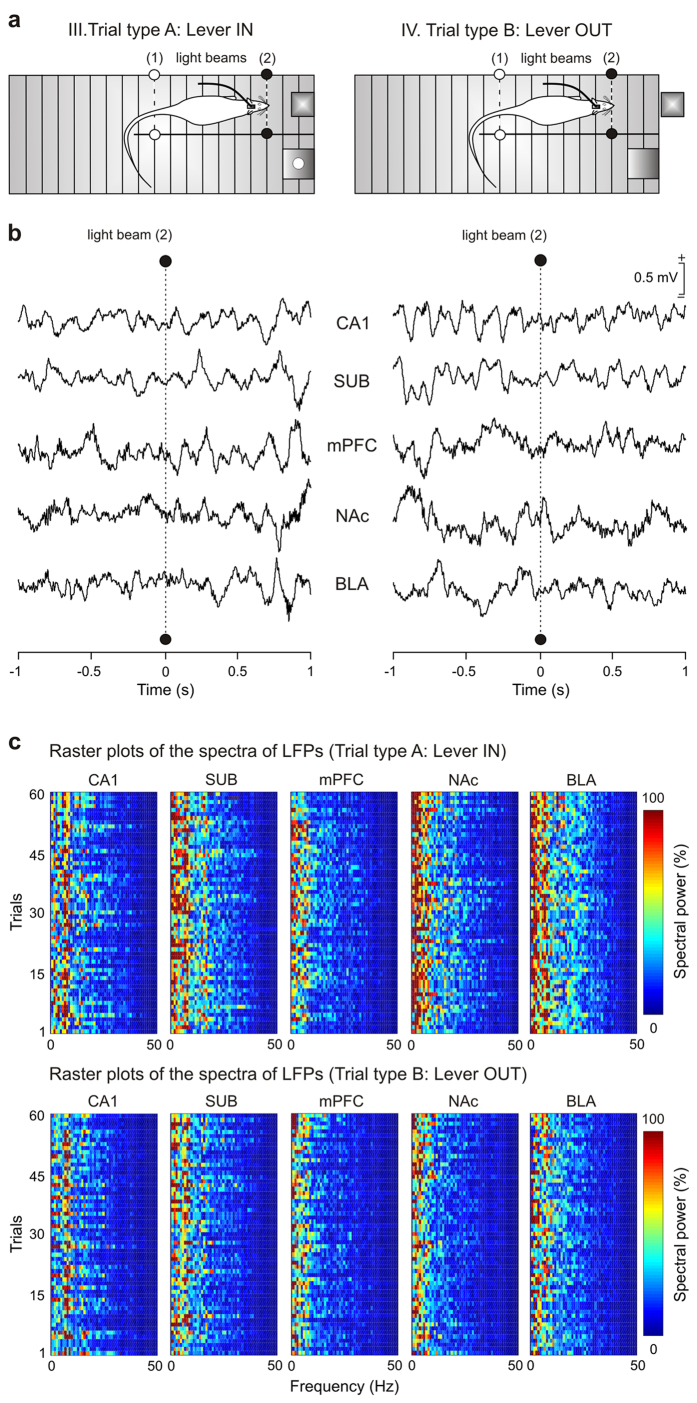
Changes in LFPs evoked at the five recording areas during Type A (Lever IN) and Type B (Lever OUT) trials.(a) LFPs were recorded at the five (CA1, SUB, mPFC, NAc, BLA) selected areas from 1 s before to 1 s after the animal’s head cut (dotted line) the 2nd light beam (2, black dots), during both Type A (Lever IN) and Type B (Lever OUT) trials. (b) Representative samples (35/electrode) of 2-seconds epochs of LFP activity collected from the five cortical and subcortical areas for situations A and B. (c) Color raster displays of the power spectra (spectral power, in %, see the color bar; and frequency, in Hz, see x-axis) across 60 trials (see y-axis) of LFPs recorded from the five different brain sites and for the two experimental conditions (Trial type A: Lever IN; and Trial type B: Lever OUT). LFPs were selected from 1 s before to 1 s after crossing the 2nd light been (2) as illustrated in (b). Spectral powers presented predominant values in the frequency range of 1–25 Hz with the low-theta band (3–8 Hz) as the fundamental frequency band. Spectral powers were normalized according to their maximum inter-channel (sites) value.